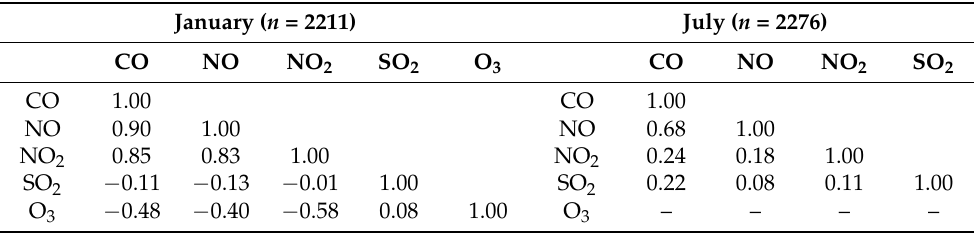
Table 2. Correlation matrix of 20 min concentrations of gaseous pollutants in Irkutsk.